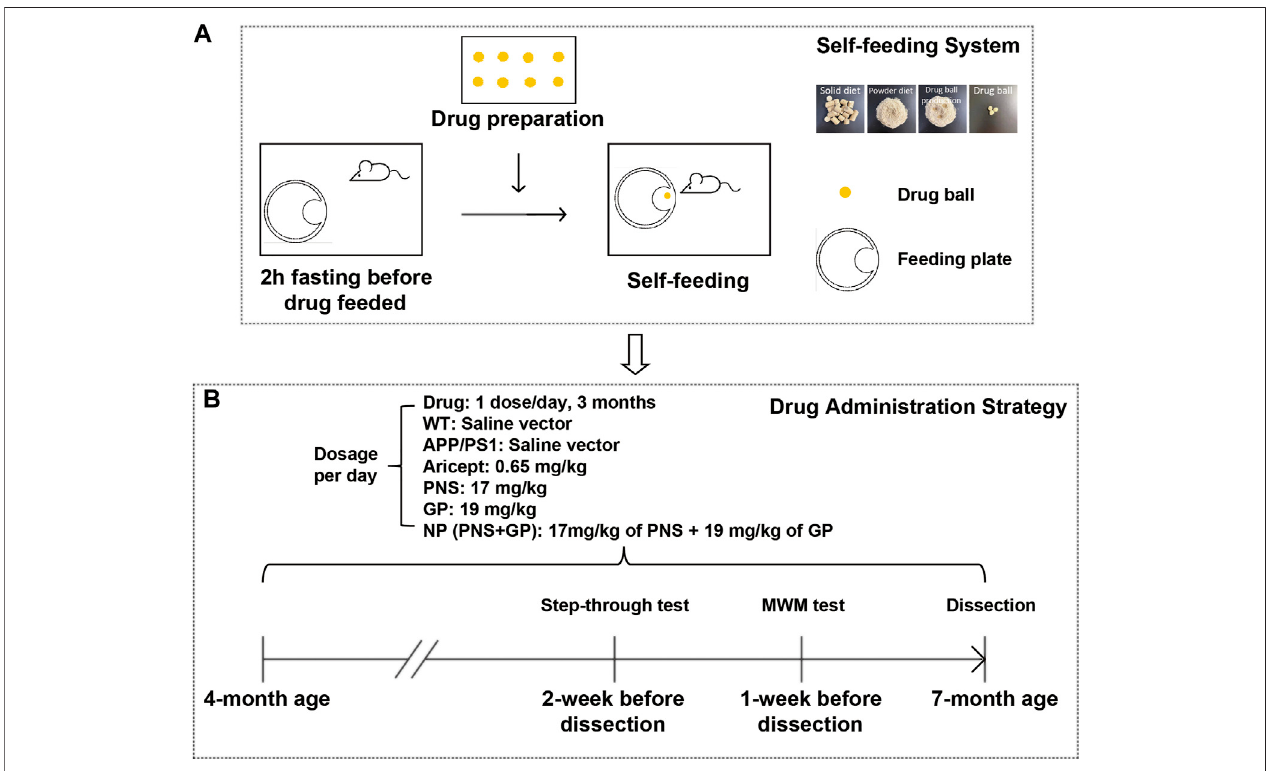
FIGURE 1 | Introduction of the self-feeding system and early intervention strategy. (A) Sketch of the self-feeding system. Drugs were mixed in food powder to produce drug balls. Driven by hunger, mice were trained to feed. (B) Timeline for early intervention and behavioral experiment schedule in APP/PS1 transgenic mice.